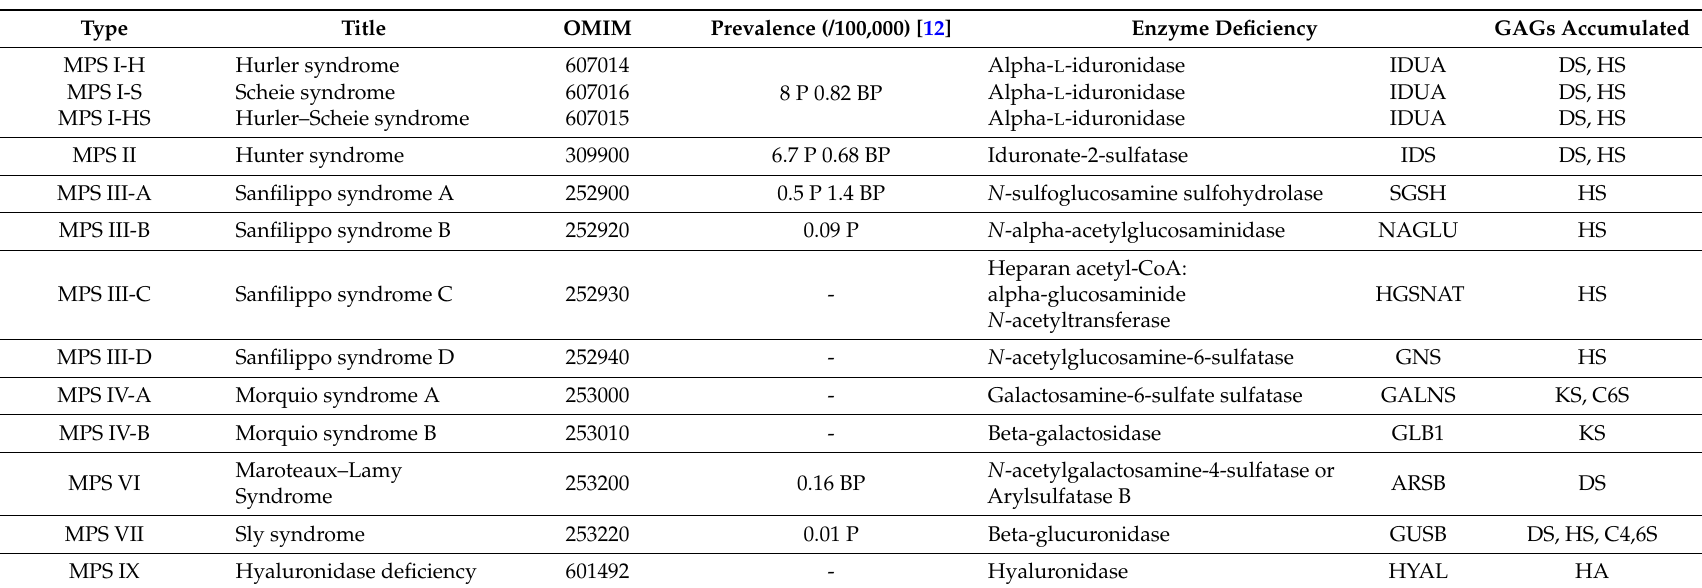
Table 3. The most important data in